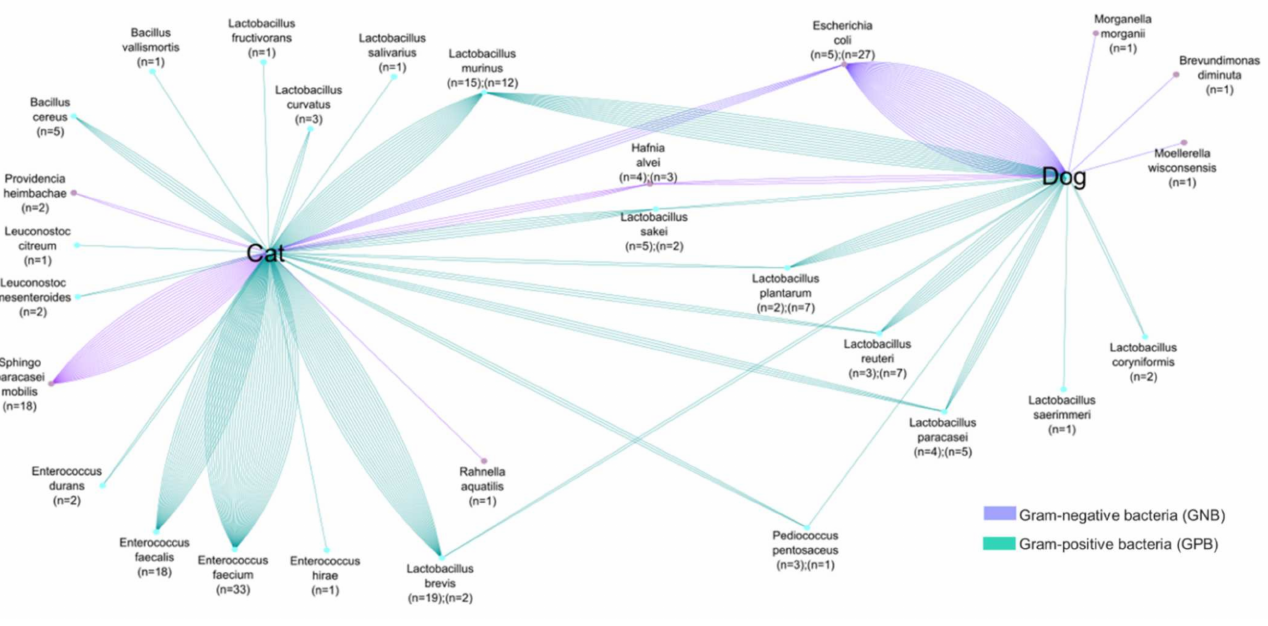
Figure 3. Comparative analyses of common colistin-resistant bacterial species found in the fecal samples of dogs and cats. The number of strains is proportional to the number of